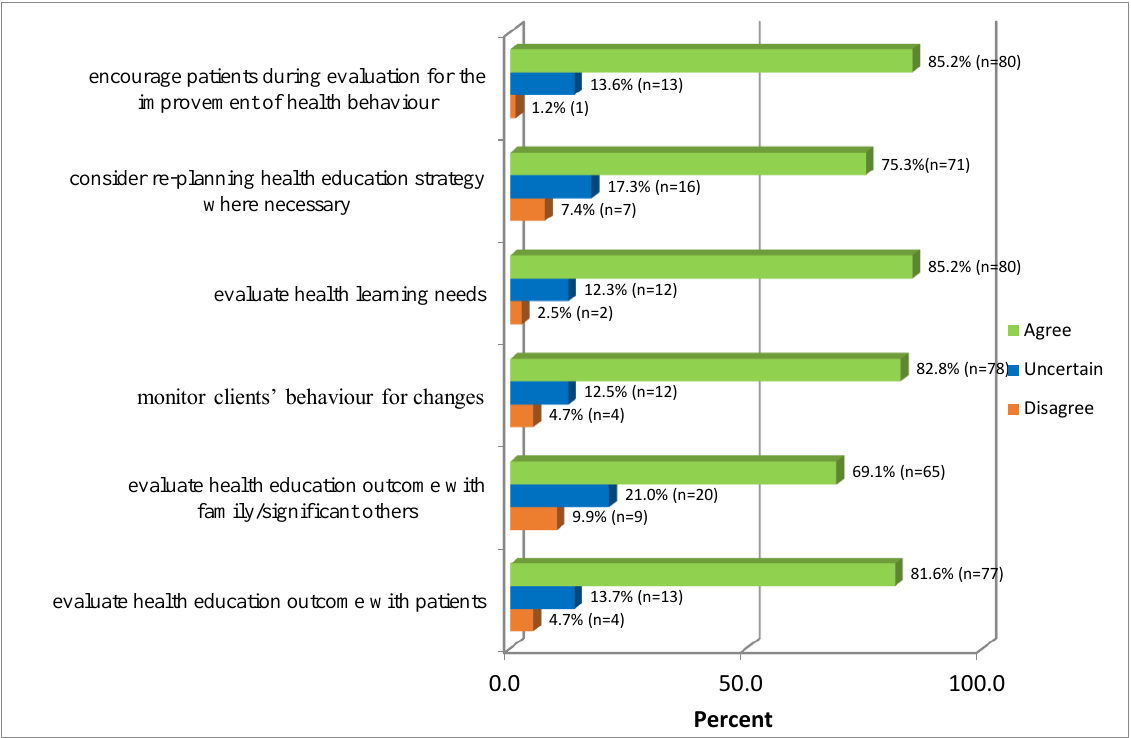
Figure 3: Ability of Novice nurses to evaluate the outcome of health